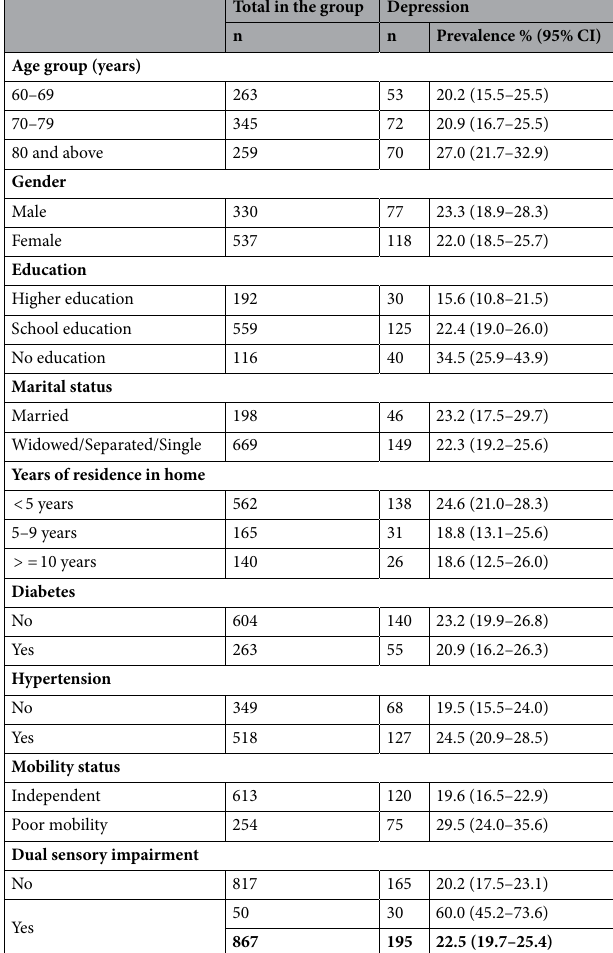
Table 1. Illustrates the characteristics of the study sample stratified by presence or absence of a depression (n = 867) – Univariable analysis.